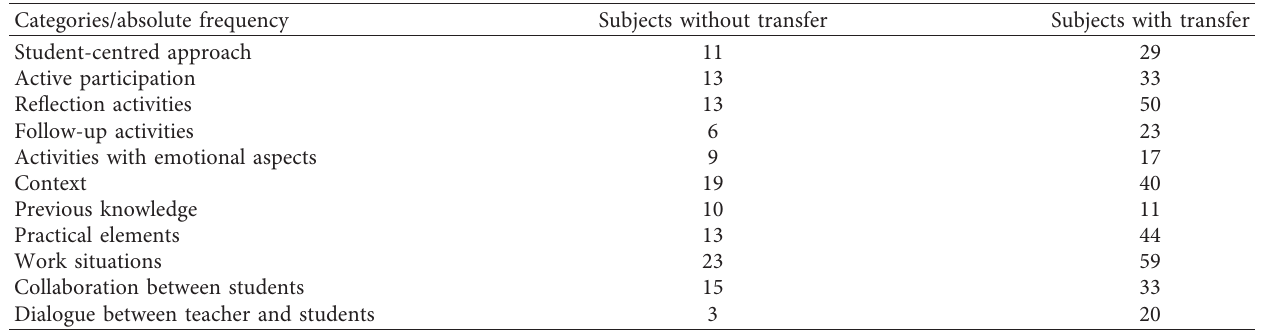
Table 1: Incidence of the categories and absolute frequency in each group.